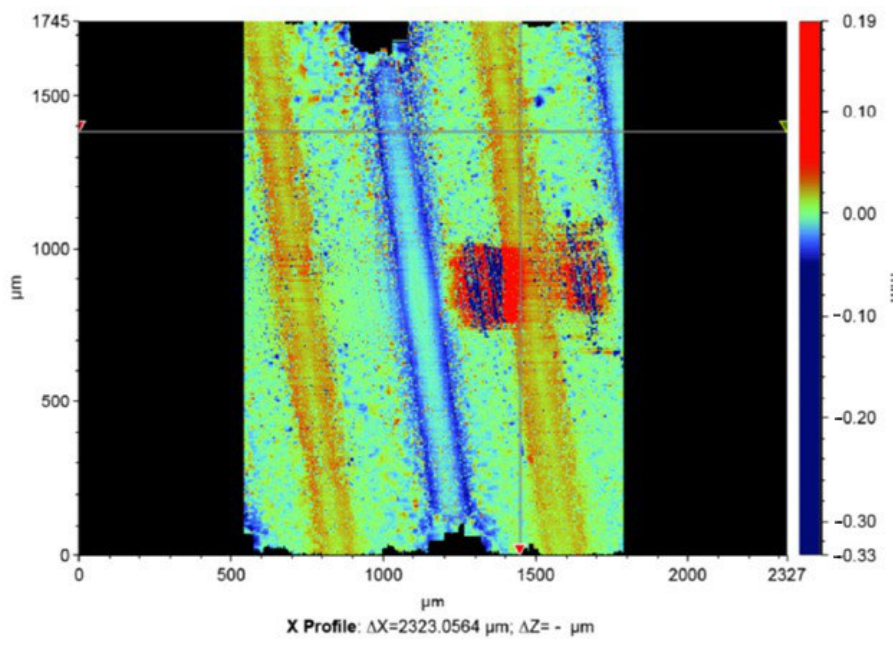
Figure 7. Thread surface quality before thermal pulse processing.